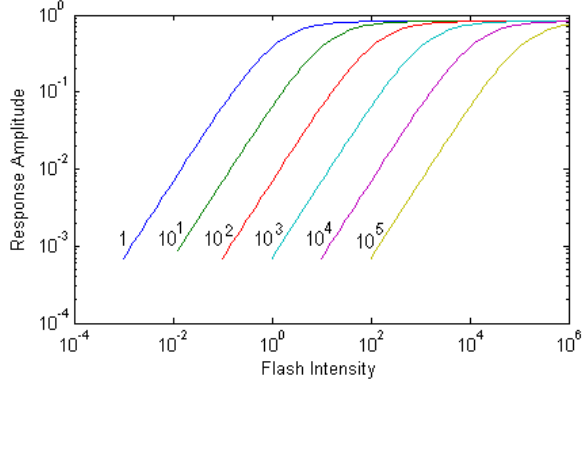
Figure 4. Model of Response of photoreceptor at different adaptation levels. Adapted from